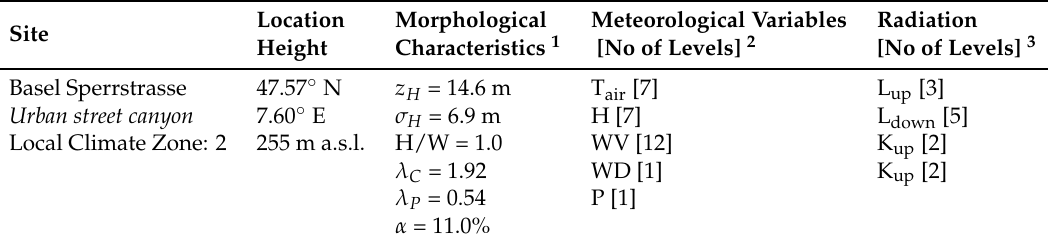
Table 1. A description of morphological parameters and measured variables for the selected urban and rural sites from the Basel Urban Boundary Layer Experiment. Modified from Rotach et al. [13] to include only relevant parameters.